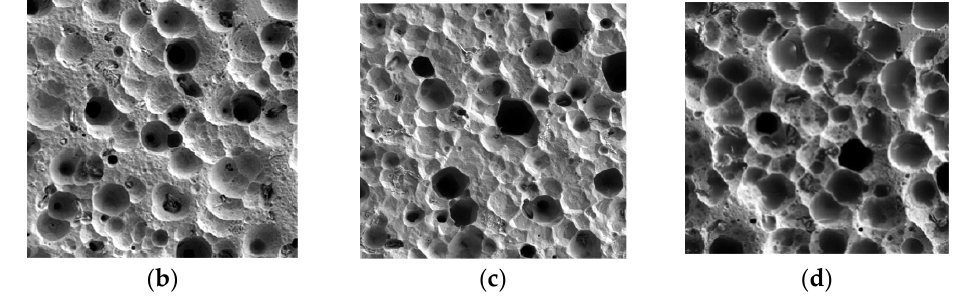
Figure 2. Electrochemical impedance spectroscopy at different Cl − concentrations: ( a ) low Cl − concentrations; ( b ) high Cl − concentrations.